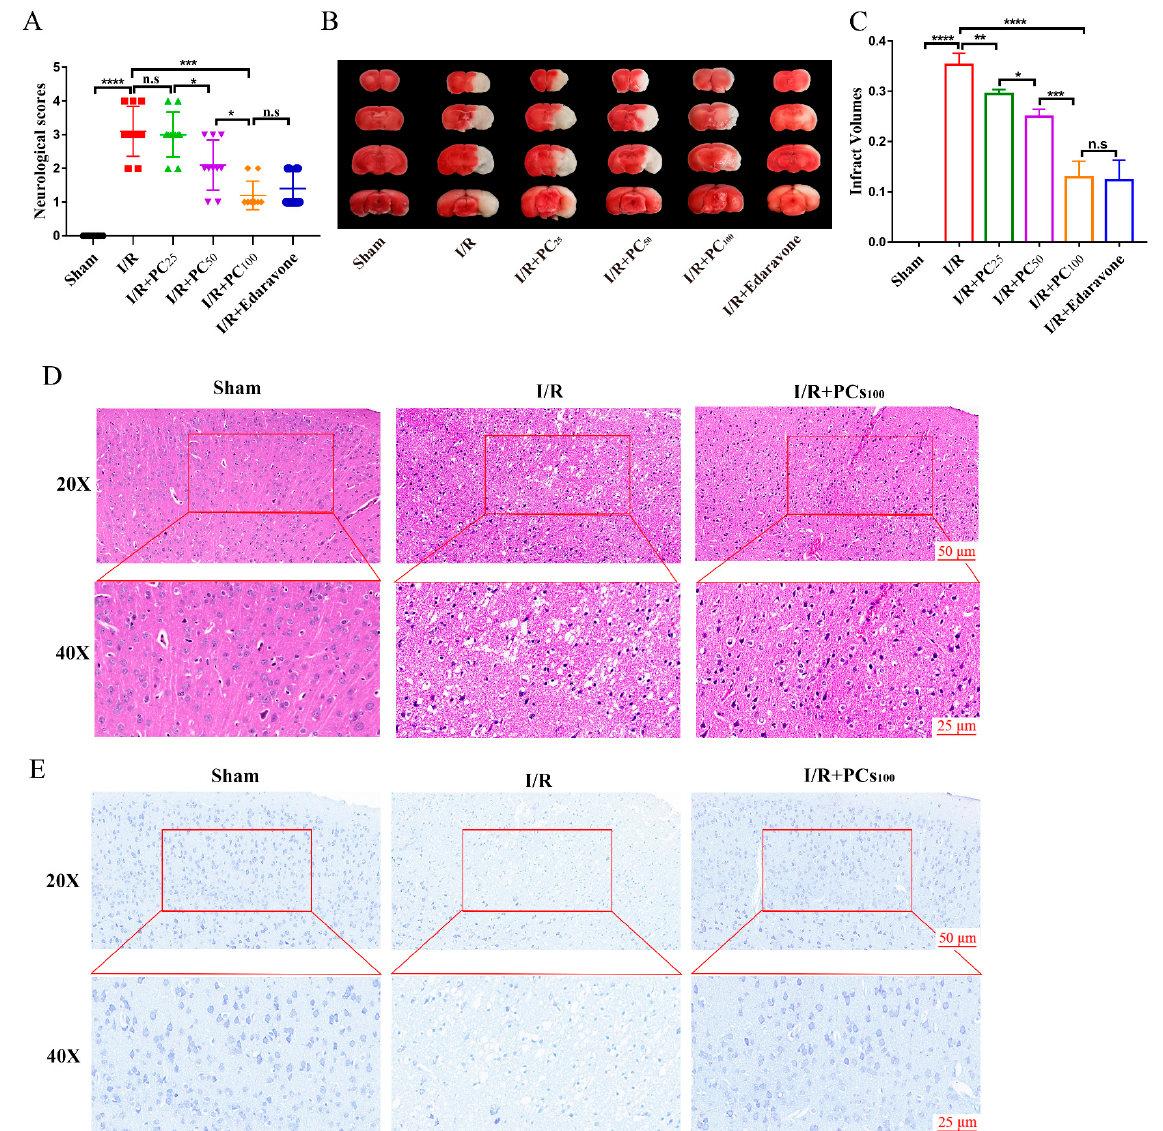
Figure 2. Effects of procyanidins on the neurological deficit, cerebral infarct volume, and pathological lesions following MCAO/R in mice. ( A ) Neurological scores of mice with CIRI (n = 10). ( B , C ) The cerebral infarct volume in mice after CIRI (n = 6). ( D ) Representative HE-stained sections of mouse cortex. ( E ) Representative Nissl − -stained sections of mouse cortex. n.s: no significant difference, * p < 0.05, ** p < 0.01, *** p < 0.001, **** p < 0.0001.